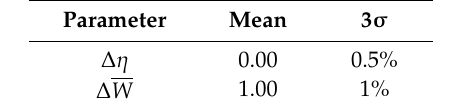
Table 1. Gaussian distribution characteristics for engine serial deviations simulations (Case 1).